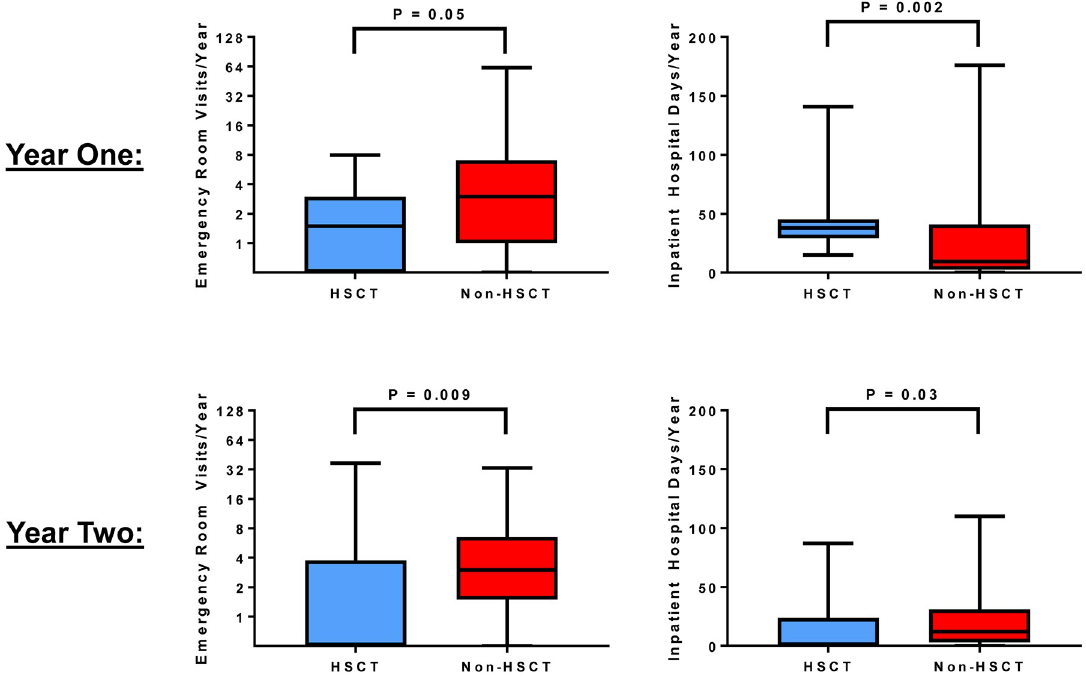
Fig 3. Comparison of emergency care and inpatient hospital days in 16 transplanted and 67 non-transplanted patients with sickle cell disease. (A) At 1 year from transplantation or the time of referral in the non-transplanted patients, emergency visits were lower (2 visits, IQR 0–3 visits vs. 3 visits, IQR 1–7 visits, respectively) while inpatient hospital days were higher (38 days, IQR 30–45 days vs. 10 days, IQR 3–39 days, respectively) in the HSCT vs. non-HSCT groups. (B) By the 2 nd year, improvements in both emergency room visits (1 visit, IQR 0–4 visits vs. 3 visits, IQR 2–7 visits, respectively) and inpatients hospital days (1 day, IQR 0–22 days vs. 12 days, IQR 3–31 days, respectively) were observed in the HSCT vs. non-HSCT